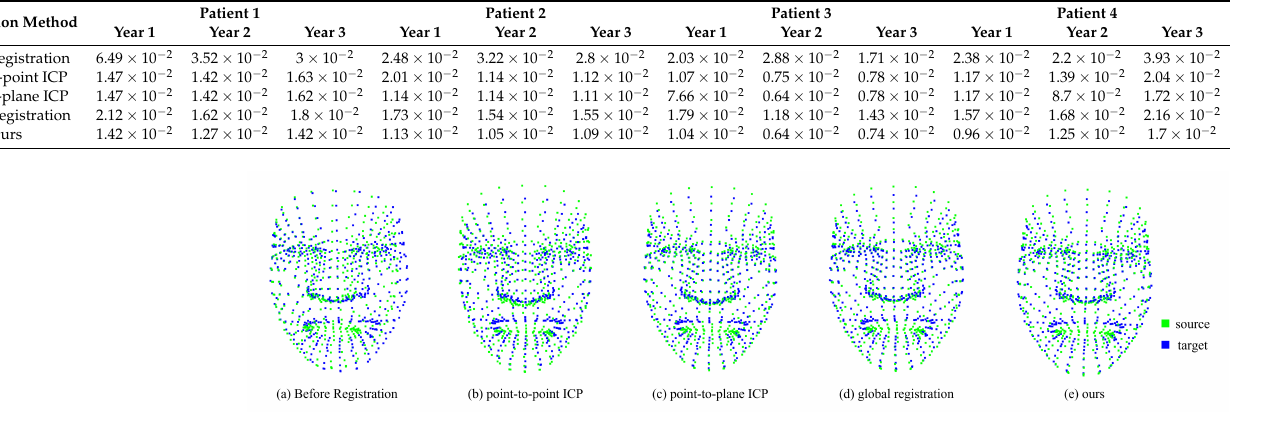
Figure 10. Registration comparison image in dynamic